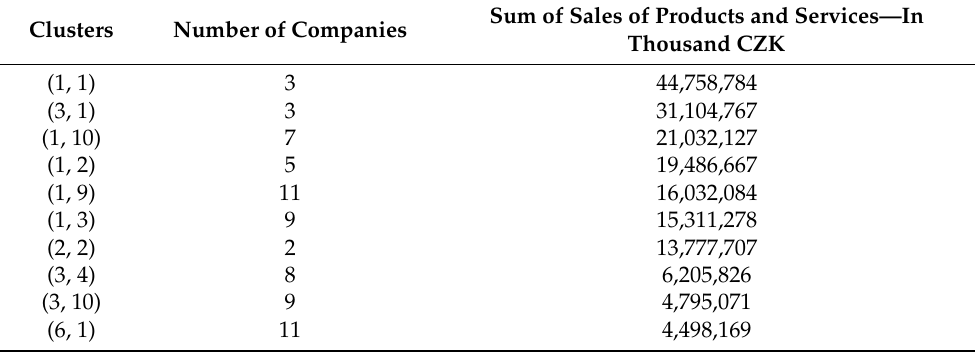
Table 21. Table of ten clusters with the highest sum of OR for the year 2015. Clusters